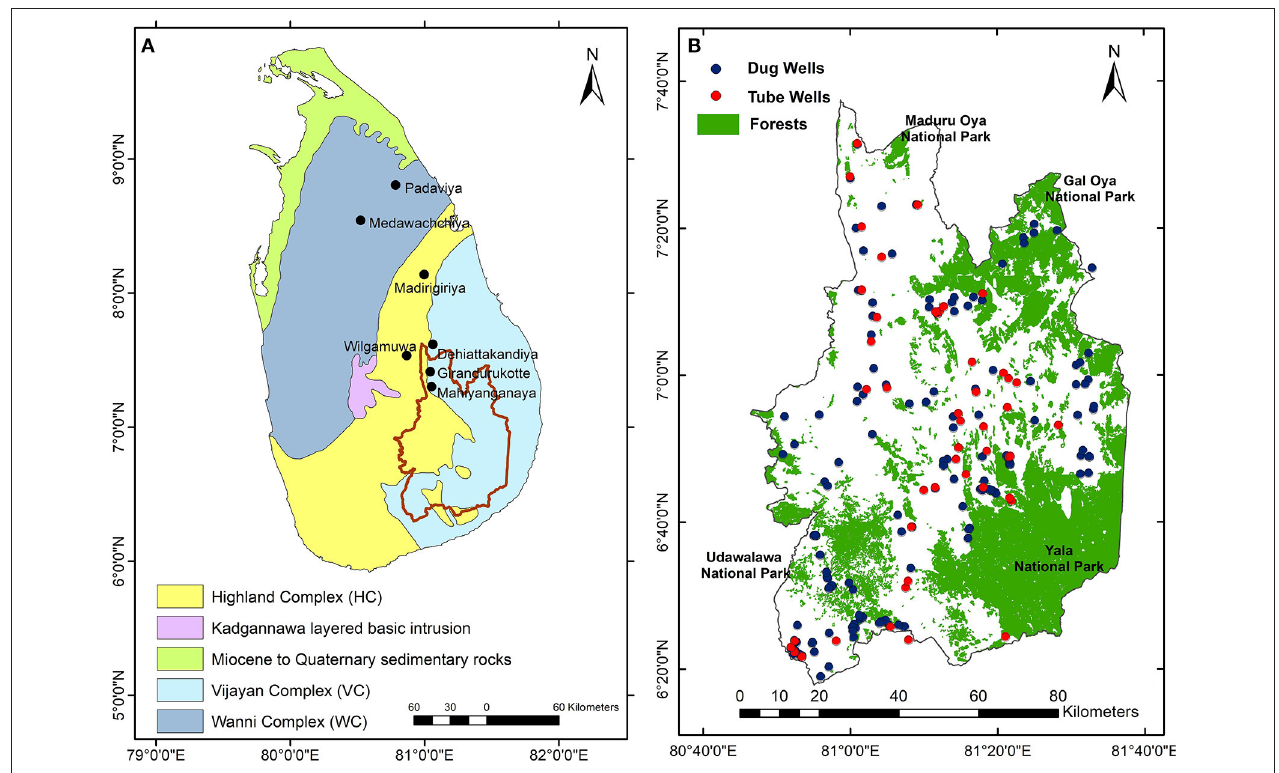
FIGURE 1 | (A) Map showing the simplified lithotectonic map of Sri Lanka (modified after Cooray, 1994) with high CKDu prevalence areas. (B) The groundwater sampling locations of the study area. Source of the forest layer: Survey Department of Sri Lanka (2018).